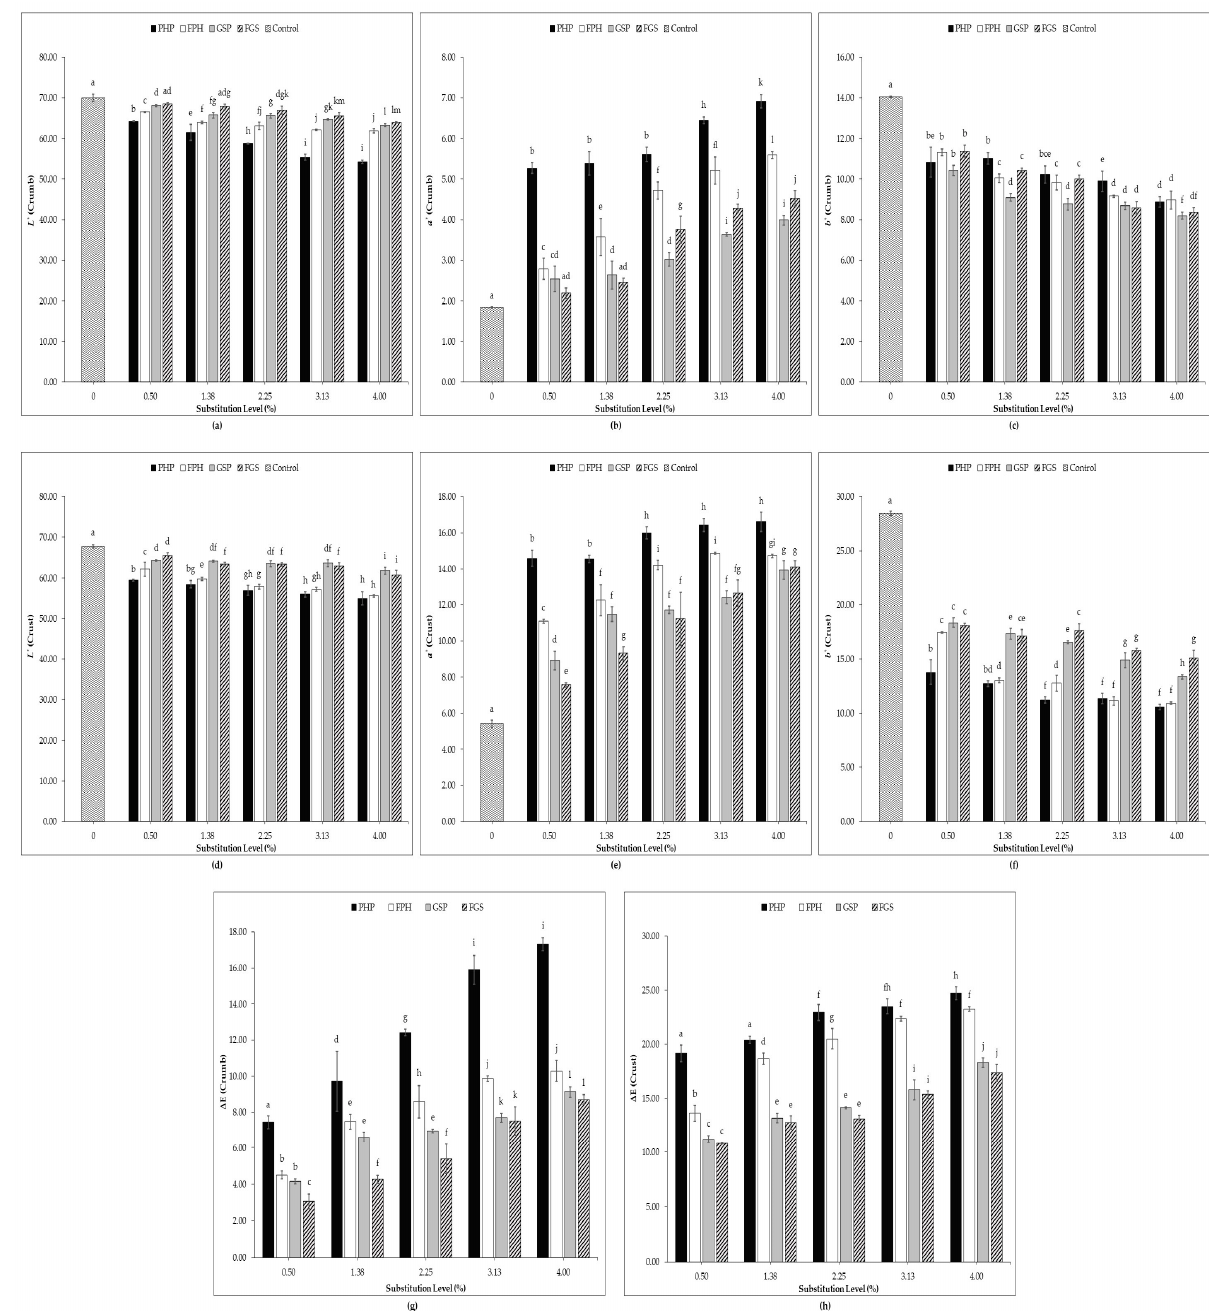
Figure 2. Crumb L* ( a ), crumb a* ( b ), crumb b* ( c ), crust L* ( d ), crust a* ( e ), crust b* ( f ), crumb color change ( g ), and crust color change ( h ) of the control and enriched breads. Values of each parameter with the same letters were not significantly different ( p > 0.05).